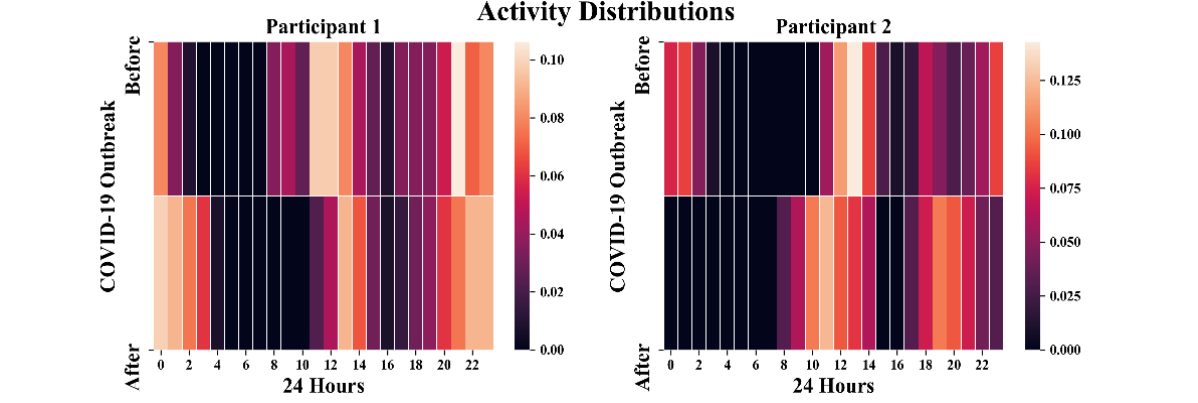
After that, for each of the 24 hours ( h ) of a user, we calculated the percentage (ie, relative) change of online activities before and after the